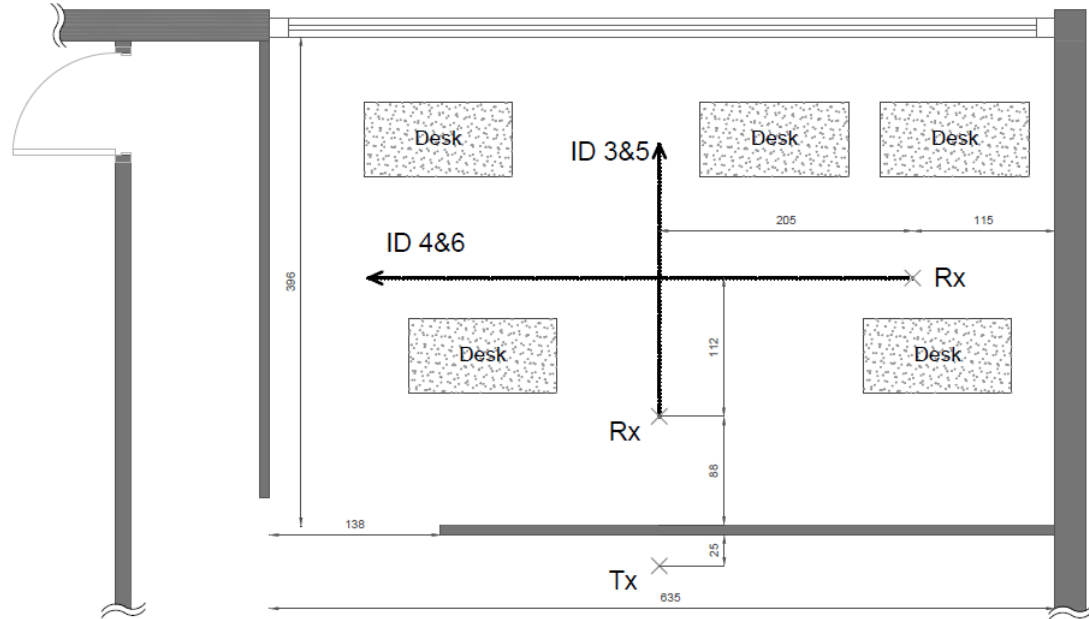
Figure 5. Floorplan of the office (furnished) with dimensions in cm.